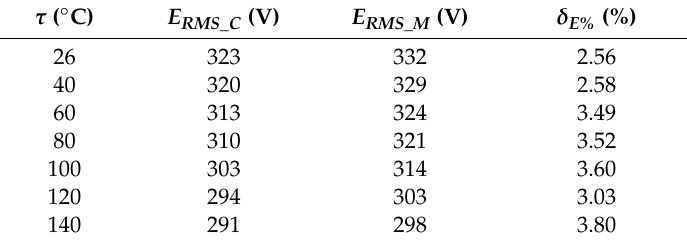
Figure 5. Calculated and measured e L 1– L 2 ( t ) waveforms in: ( a ) τ = 26 ◦ C and ( b ) τ = 140 ◦ C. Table 2. Summary of the RMS of the BEMF and BEMF coefficient δ E % .